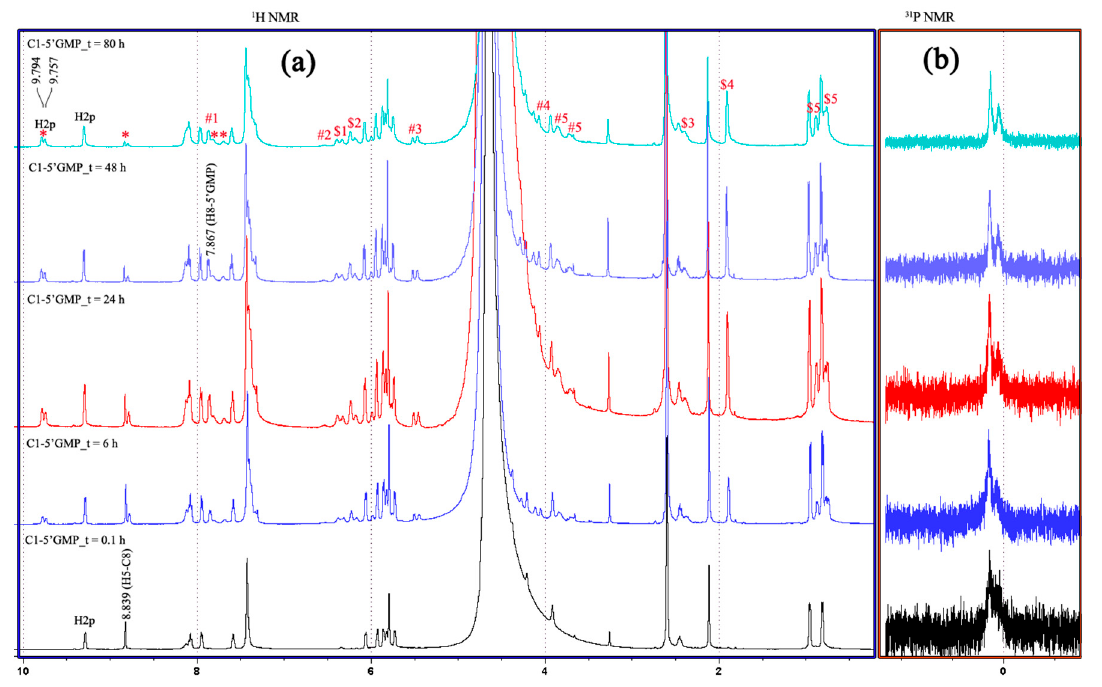
Figure 3. 1 H NMR spectra (column a ) and 31 P{1H} NMR spectra (column b ) for the time-dependent interaction of C1 and 5 ′ -GMP in 10% DMSO-d 6 -phosphate buffered D 2 O (pH 7.4) over 80 h. Chemical shifts ( δ ) are reported in parts per million (ppm).